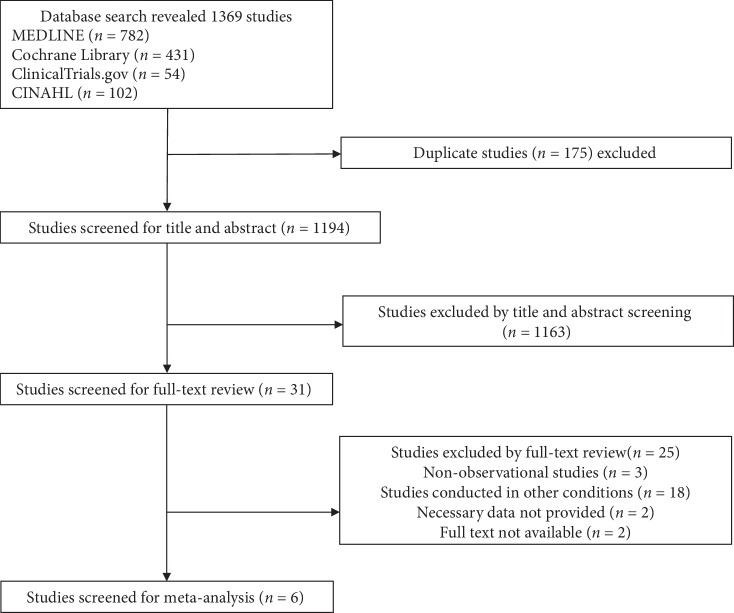
Study flow diagram.